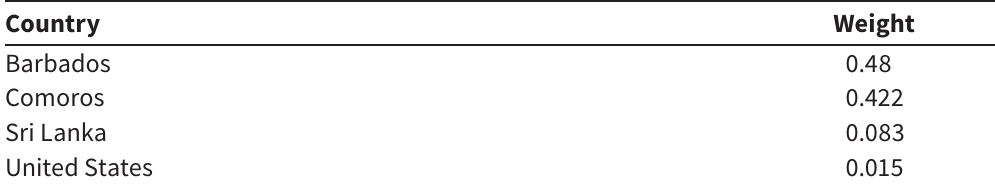
Weights for Constructing Synthetic Puerto Rico (Limited Donor